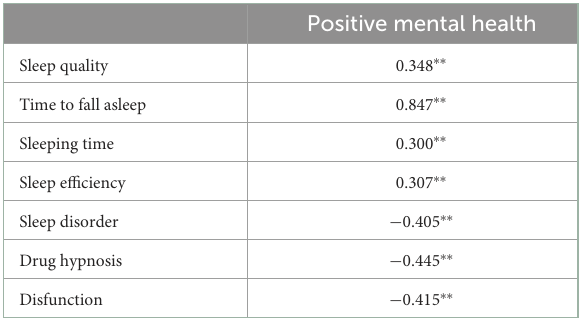
TABLE 8 Fitting degree of multiple regression model for children’s sense of safety.